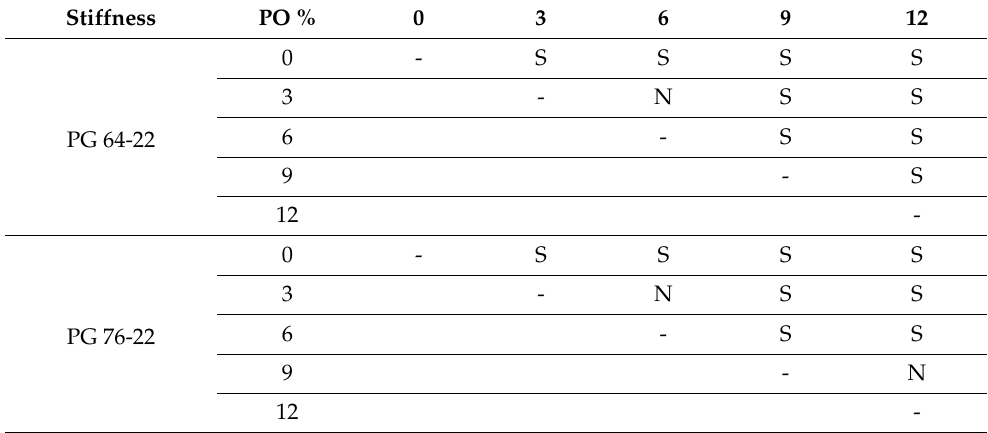
Table 8. Statistical analysis results of the stiffness as a function of processed oil content at − 12 ◦ C ( α = 0.05).